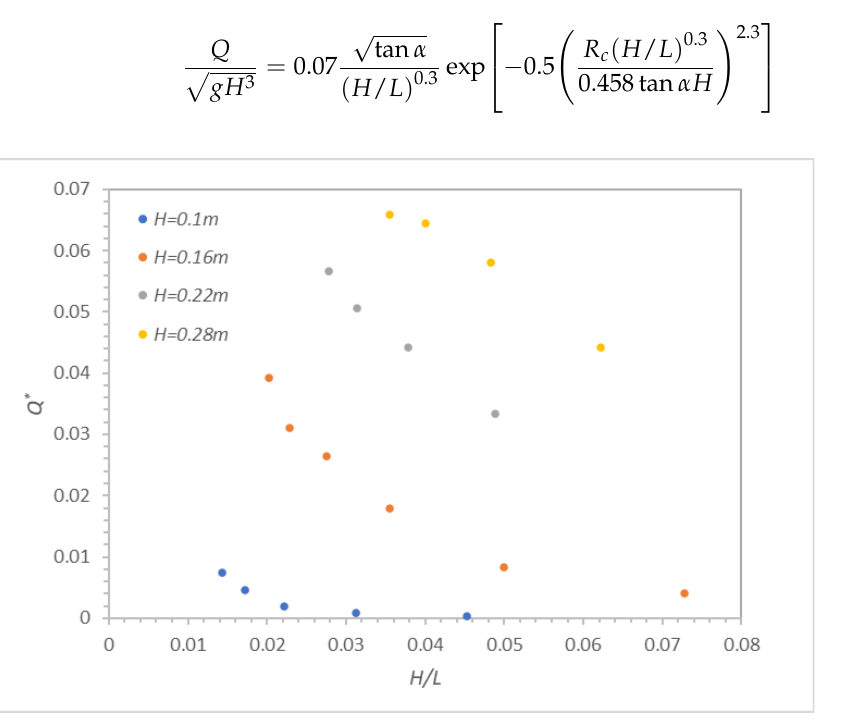
Figure 10. Relationship between dimensionless parameter Q* and H/L.